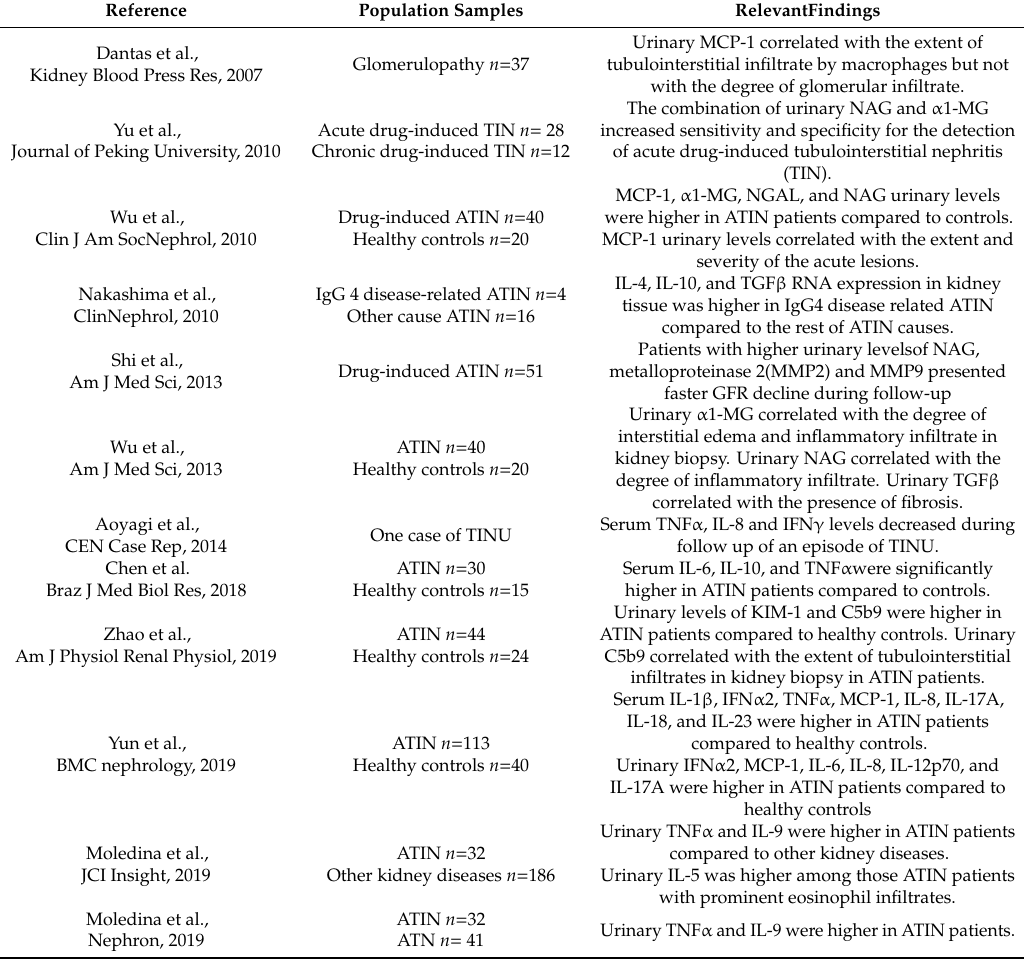
Table 1. Summary of the main publications related to serum and urinary biomarkers of acute tubulointerstitial nephritis